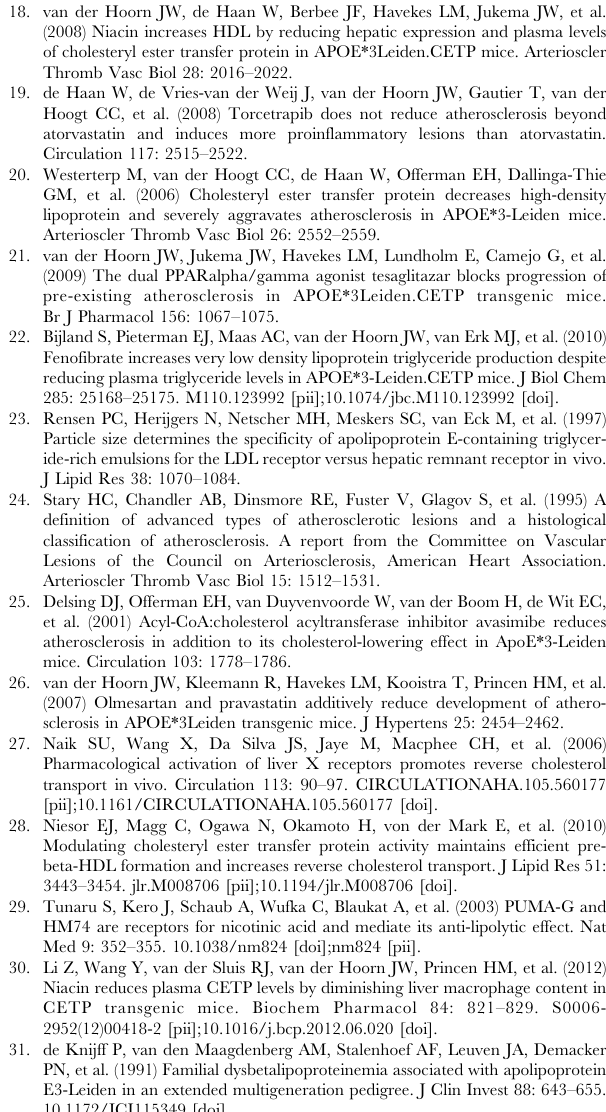
Table S1 RT-PCR primer